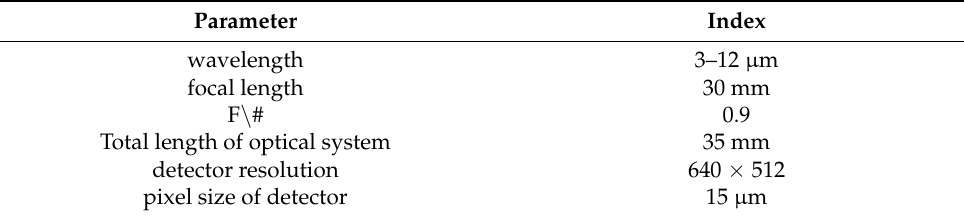
Table 1. Parameters of wide band infrared optical